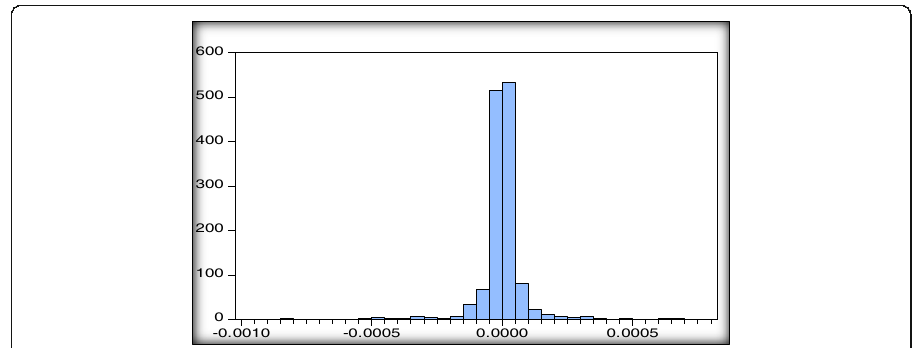
Fig. 4 Histogram representing the difference in log price of R* SHARES GETF. In the histogram, the horizontal axis represents the difference in log price and the vertical axis represents the number of times each value occurs, i.e.: it is the probability density function of the difference in log price of R*SHARES GETF